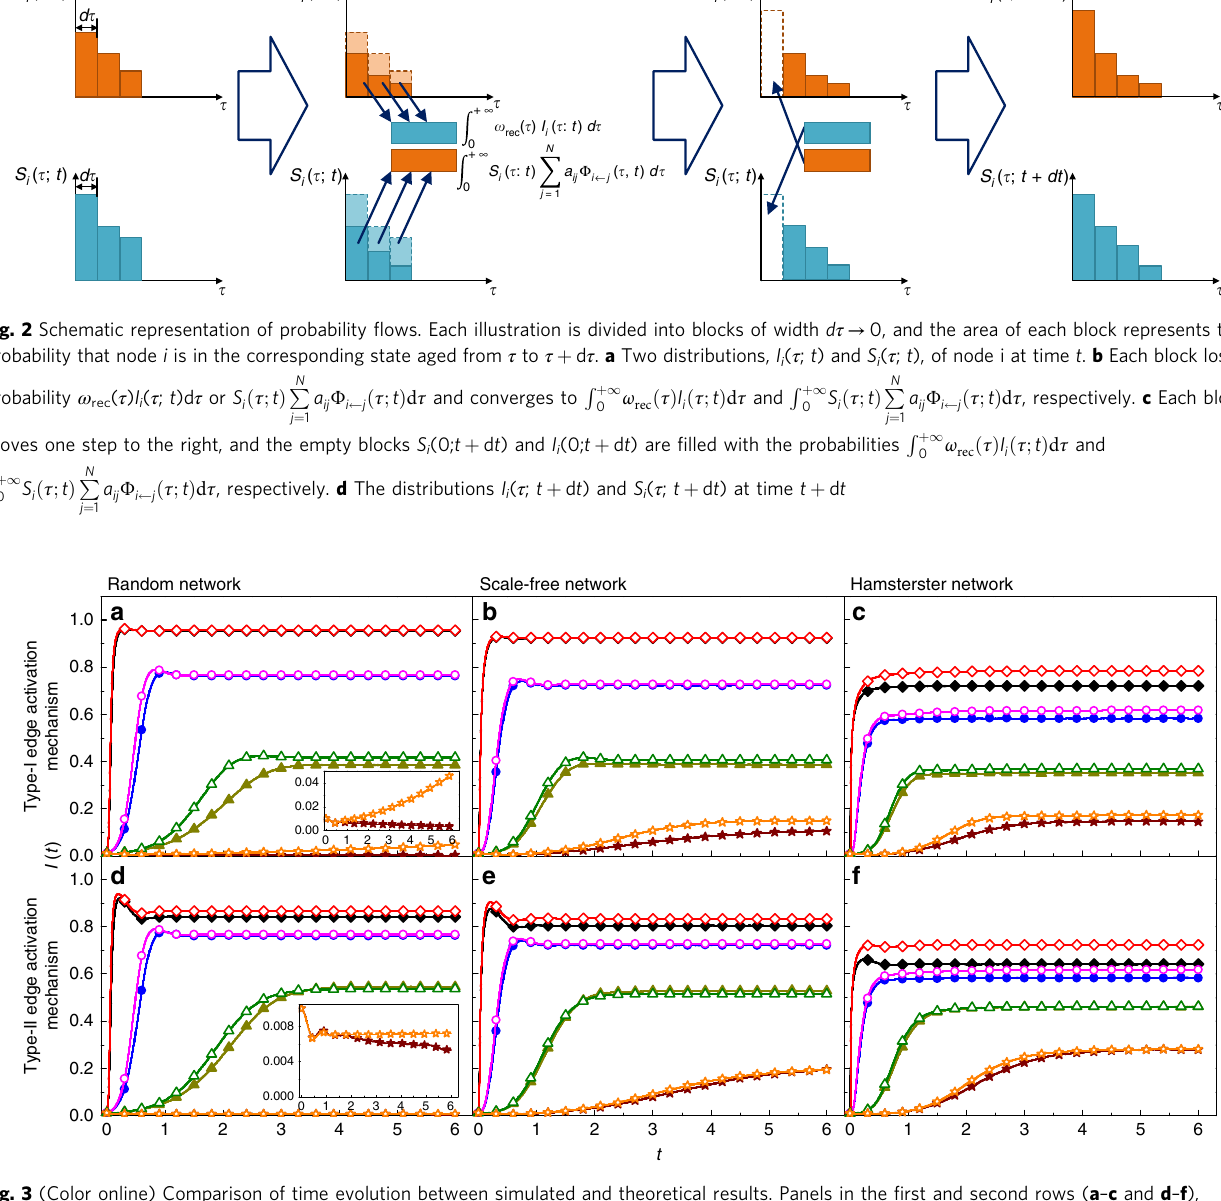
Fig. 3 (Color online) Comparison of time evolution between simulated and theoretical results. Panels in the fi rst and second rows ( a – c and d – f ), respectively, are for the type-I and type-II mechanisms. The three columns from left to right are for ER random, BA scale-free, and Hamsterster networks, respectively. In all panels, the solid symbols represent the results of simulations which are averaged over 100 realizations for random and scale-free networks, and over 400 realizations for the Hamsterster network. The open symbols represent the results of theoretical solutions obtained from Eqs. (10) – (13). The symbols diamonds, circles, triangles, and stars correspond to α I = 0.5, 1, 2, 4, respectively. The random and scale-free networks have size N = 10 4 and mean degree 〈 k 〉 ≈ 10, and the Hamsterster network has N = 2426 and 〈 k 〉 ≈ 13.7. The insets in panels a , d show the extinction process with α I = 4. Other parameters are β I = 1, α R = 2, and β R = 0.5